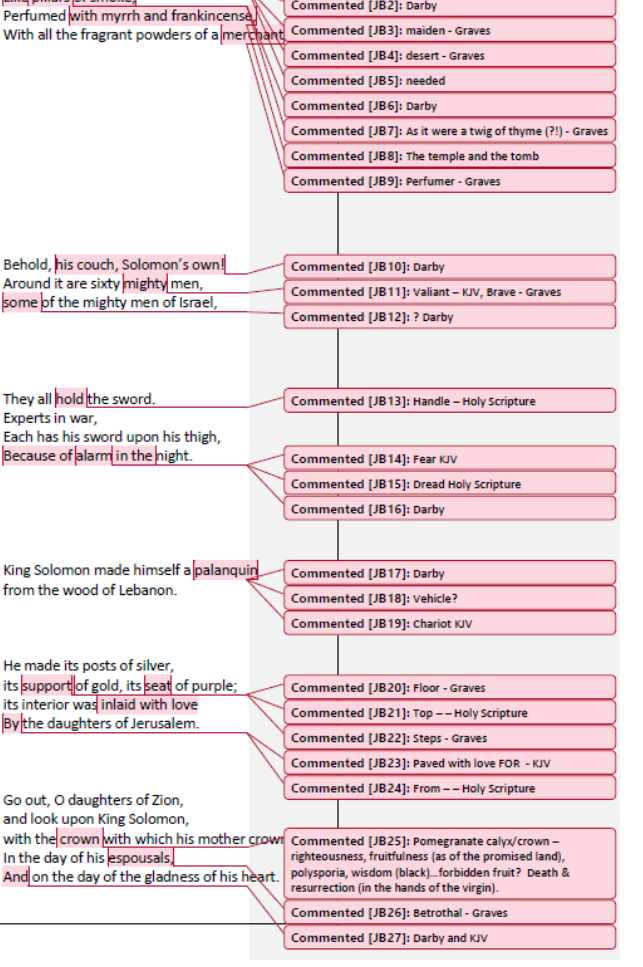
Figure 2. Bolland’s composite translation of Song of Songs